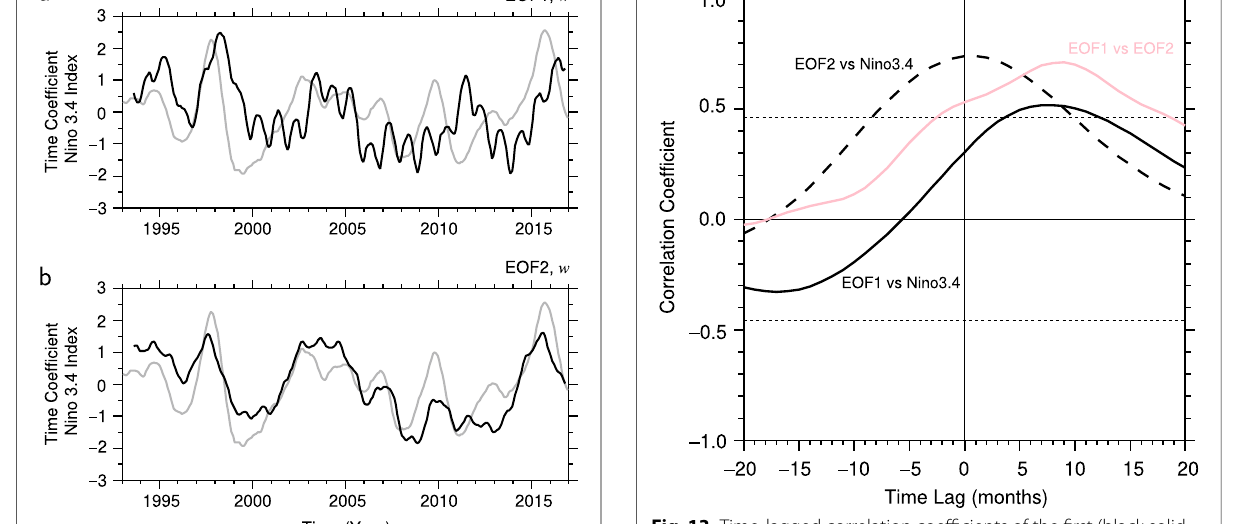
Fig. 13 Time-lagged correlation coefficients of the first (black solid line) and second (black dashed line) EOF modes of vertical velocity w with respect to Niño 3.4 index and that between the first and second EOF modes (pink solid line). The time series were smoothed by a 15-month running mean filter. The positive time lag with respect to Niño 3.4 index indicates that the EOF modes of vertical velocity lag the Niño 3.4 index. The positive time lag between the EOF modes denotes that the first mode lags the second mode. The vertical solid line denotes the zero time lag. The horizontal dotted and solid lines show the 95% confidence interval ( ± 0.46 ) and zero correlation, respectively